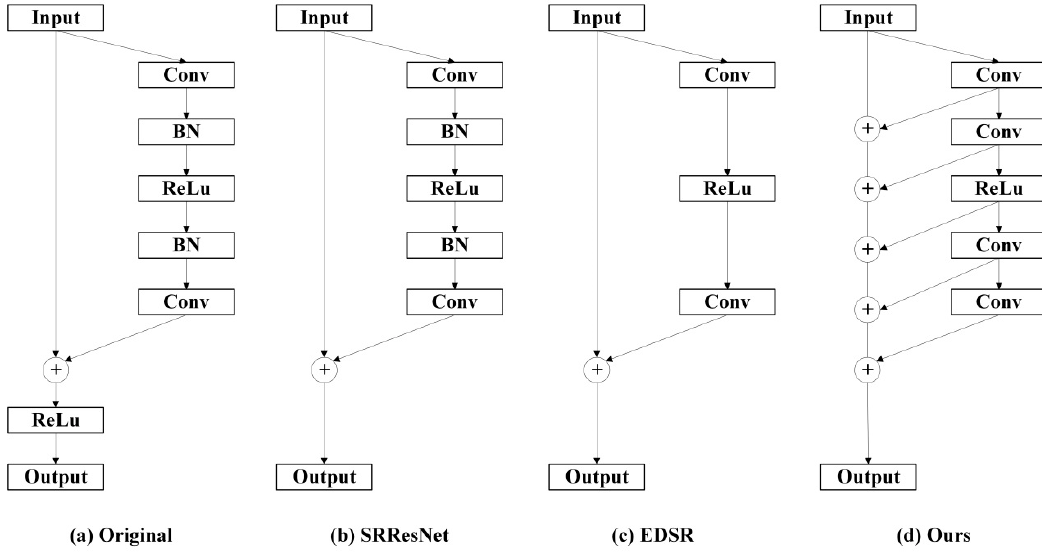
Figure 1. The comparison of different residual networks structure among the Original, SRResNet, EDSR, and our proposed.